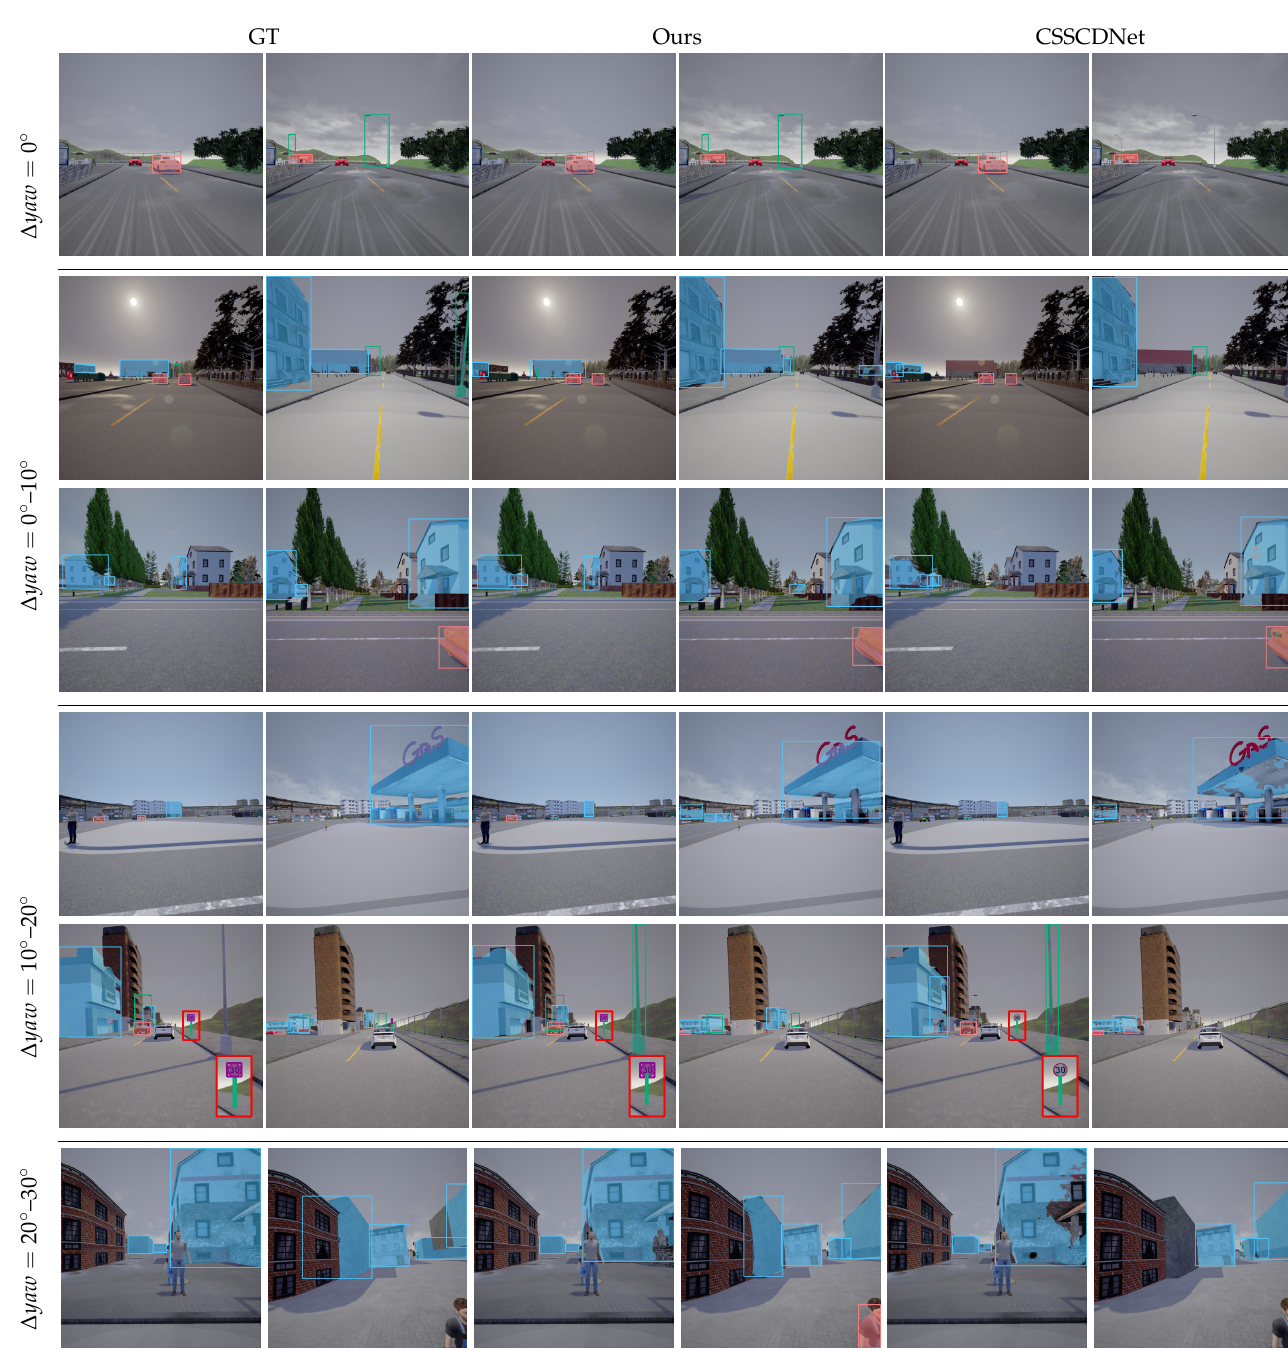
Figure 8. The qualitative results from using the SOCD dataset. Object-level changes indicated by color-coded bounding boxes: light blue for buildings, pink for cars, green for poles and purple for traffic signs. Our network was good at locating object-level changes in image